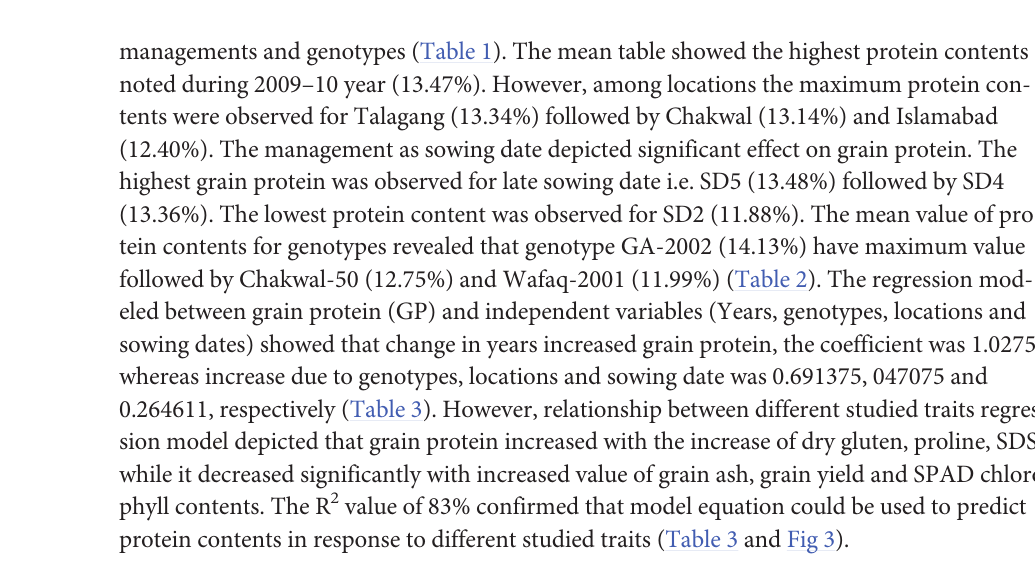
Analysis of Variance